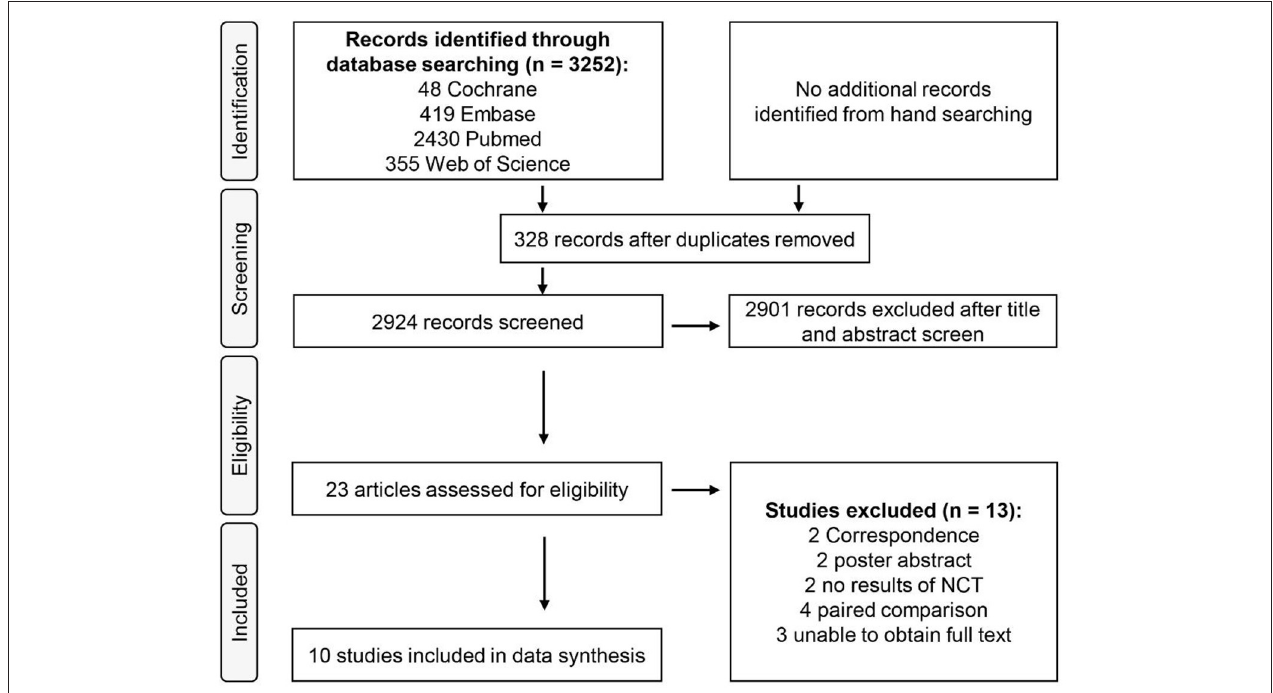
FIGURE 1 | PRISMA flowchart of included and excluded